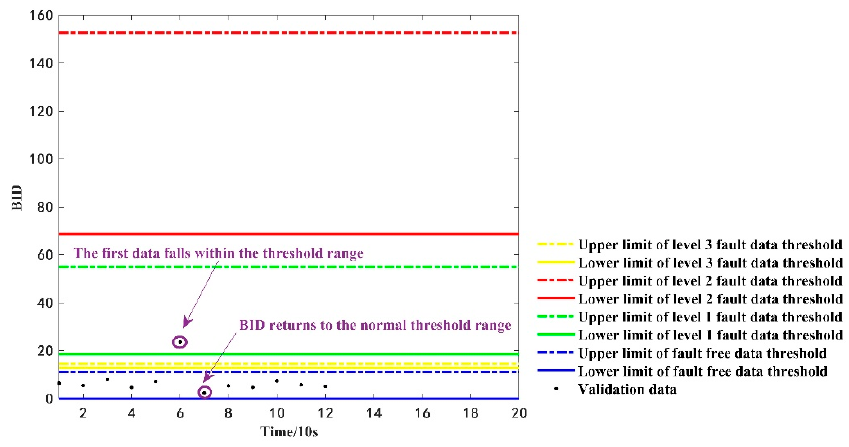
Figure 12. The discrimination results of the verified abnormal data.